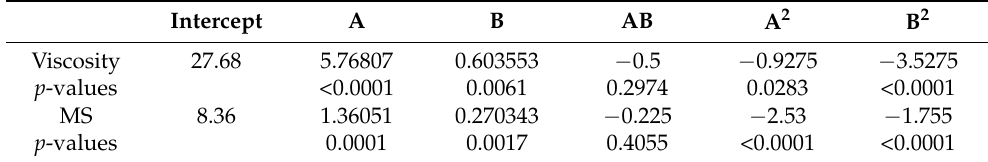
Table 5. Analysis of variance (ANOVA) results.